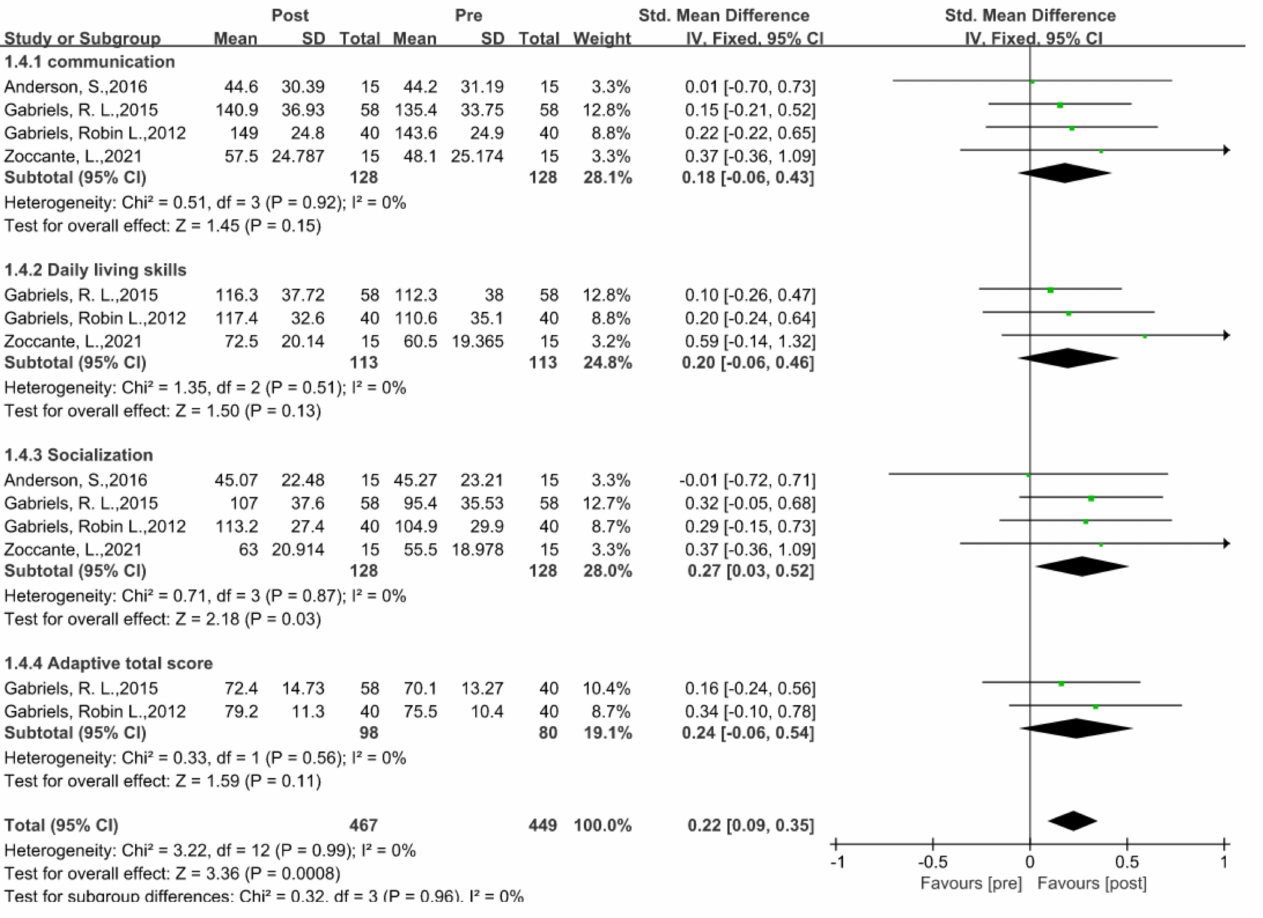
Figure 6. Forest plot of behavioral functioning (pre-post design) using VABS